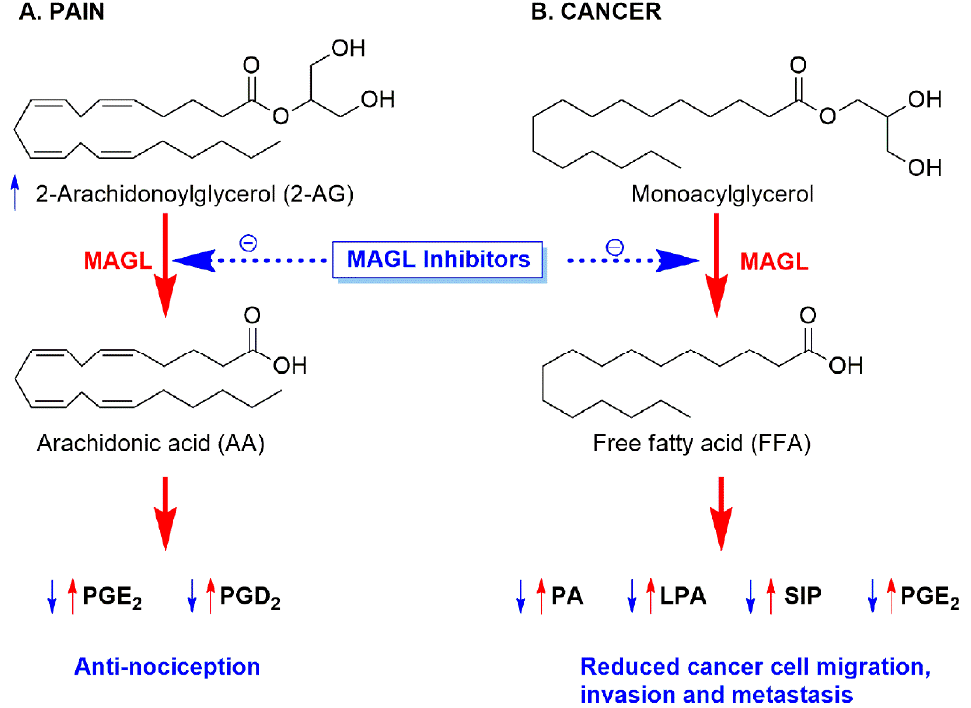
Figure 1. Role of MAGL inhibitors in the alleviation of pain and cancer. PG: prostaglandins; PA: phosphatidic acid; LPA: lysophosphatidic acid; and S1P: sphingosine-1-phosphate.